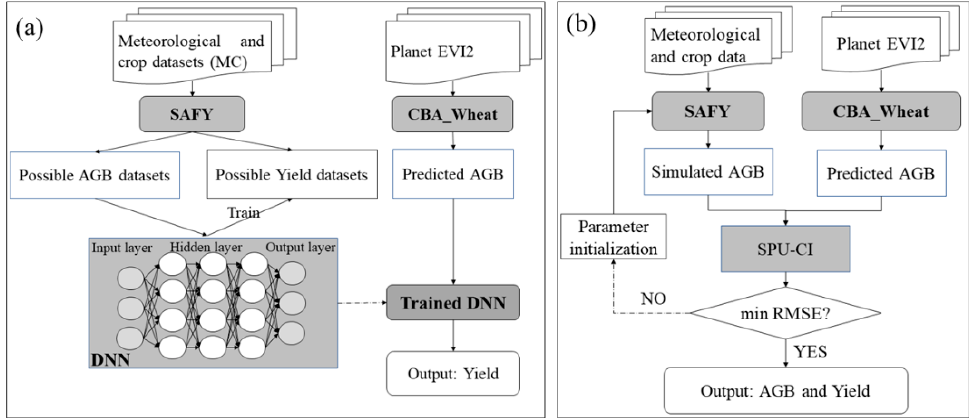
Figure 3. The flowchart of transfer learning method ( a ) and data assimilation ( b ) for winter wheat. SAFY, CBA_Wheat, DNN, SPU-CI, AGB and EVI2 represent the simple algorithm for yield model, crop biomass algorithm for wheat, the deep neural network, the Shuffled complex evolution with PCA, aboveground dry biomass and the enhanced vegetation index 2, respectively.